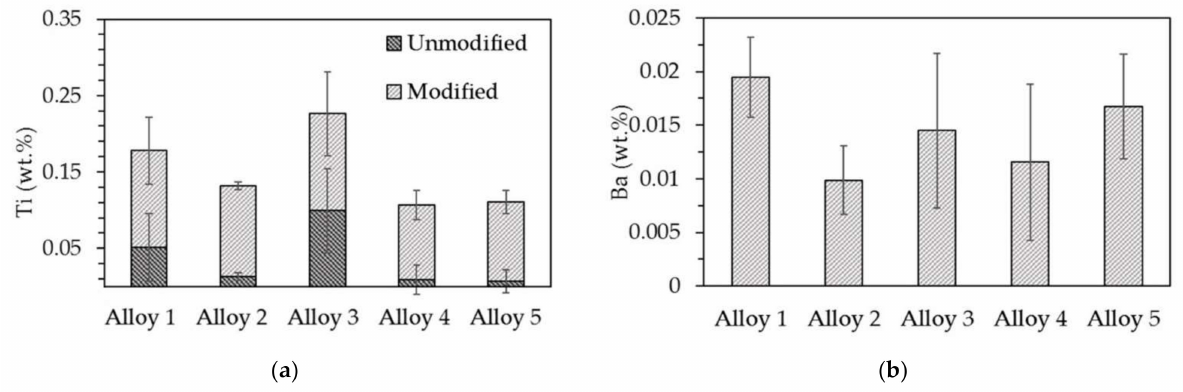
Figure 9. Mass concentration of modifying elements in Al–Si alloys according to spectral analysis data: ( a ) Ti, ( b )